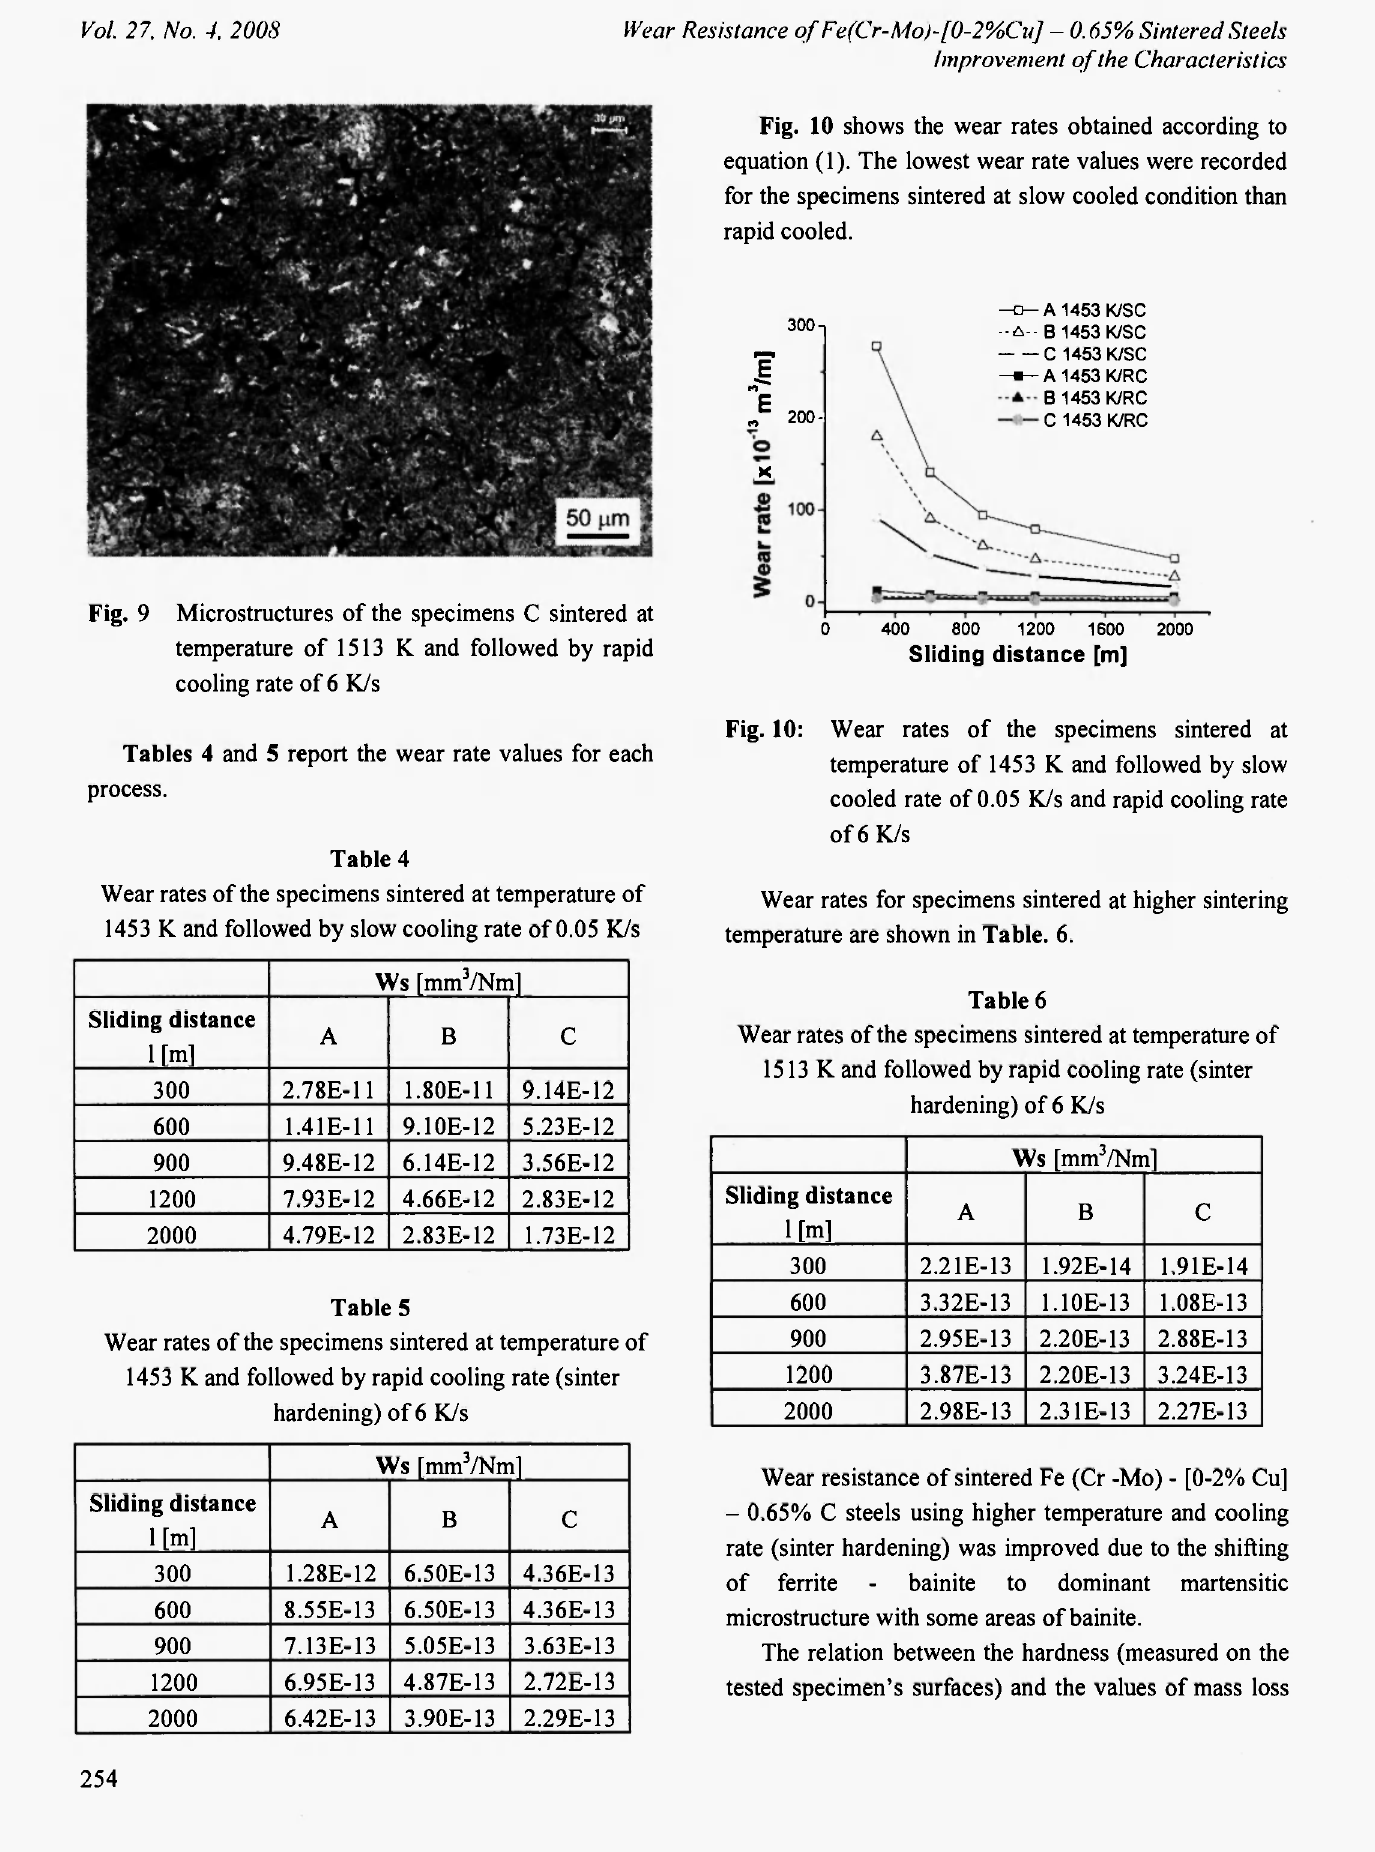
Fig. 10 shows the wear rates obtained according to equation (1). The lowest wear rate values were recorded for the specimens sintered at slow cooled condition than rapid cooled.